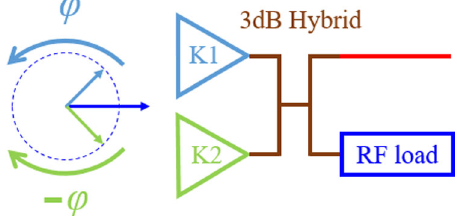
FIG. 7. Scheme of phase-to-amplitude modulation.